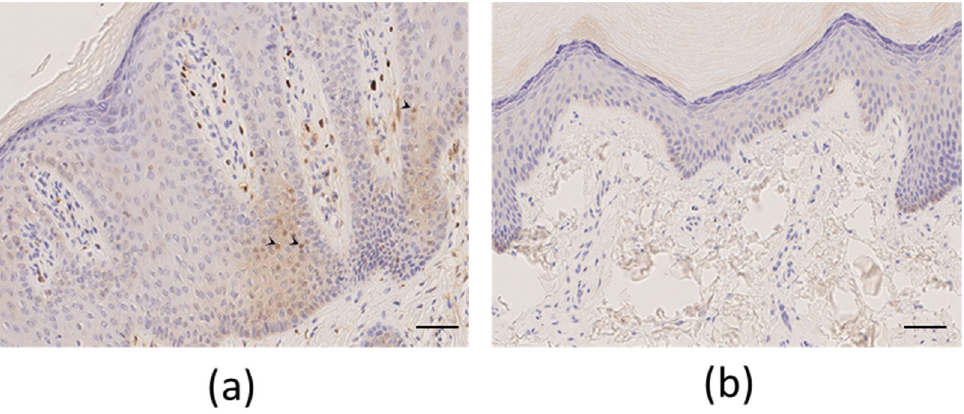
Figure 3. Phospho-extracellular-signal-regulated K-kinase (ERK) labeling—immunohistochemistry with anti-phospho-ERK antibodies. ( a ) Nuclear staining (arrowheads) of numerous keratinocytes in the supra-basal layer of hyperplastic epidermis (original magnification 40 × ) before erlotinib treatment in patient #1. ( b ) Absence of nuclear staining in normal thick skin biopsy. Scale bar 50 µm.